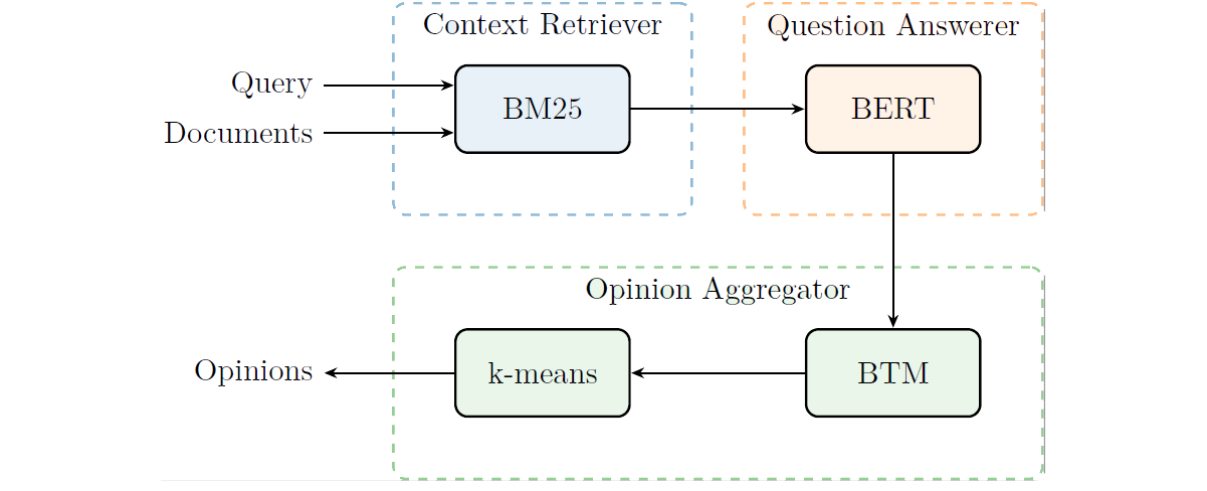
Figure 1. Illustration of the pipeline. BERT: bidirectional encoder representations from transformers; BTM: biterm topic